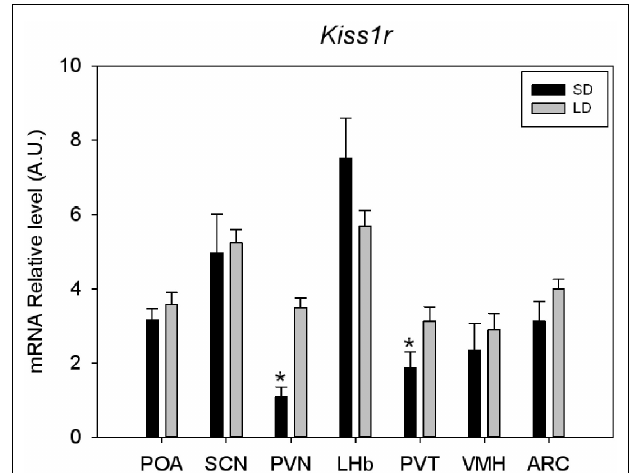
FIGURE 2 | Quantification of Kiss1r mRNA expression in various brain areas of Syrian hamsters housed in long (LD: 14h light-10h dark) or short (SD: 10h light-14h dark) day. For each structure SD value was compared to LD value and considered as significant (*) for p < 0.05. suprachiasmatic nucleus (SCN), paraventricular nucleus (PVN), lateral habenular nucleus (LHb) parventricular nucleus of the thalamus (PVT), ventromedial hypothalamic nucleus (VMH), and arcuate nucleus